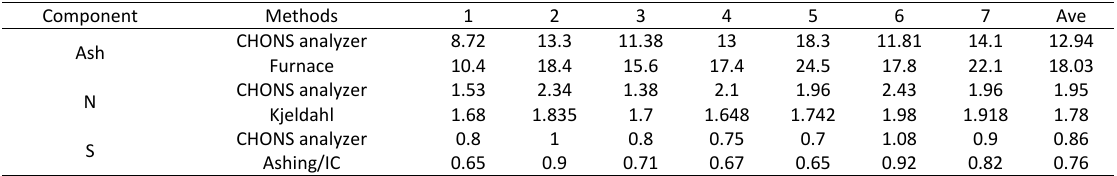
Table 4: Ash, nitrogen and sulfur determination in the samples through different laboratory methods